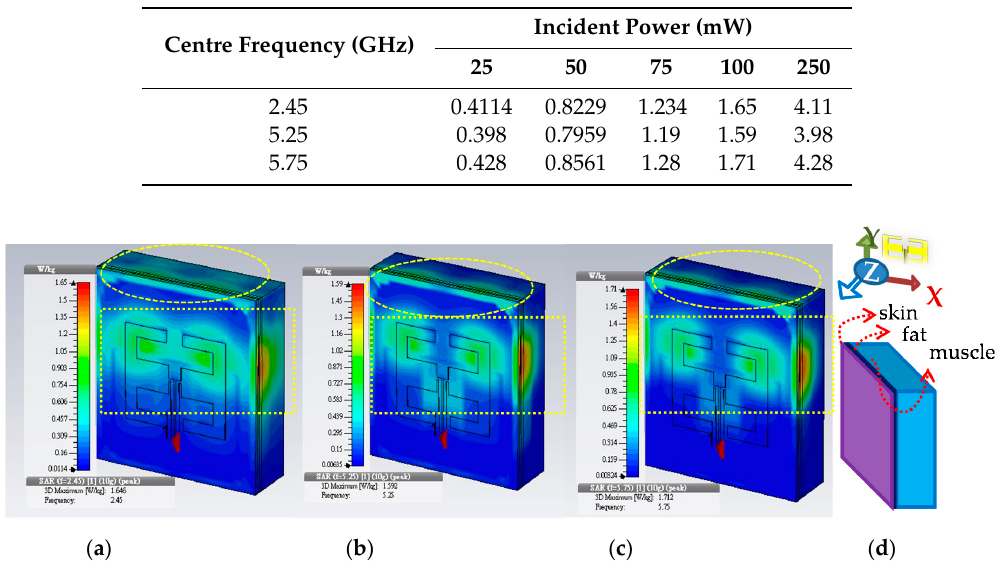
Table 3. Simulated average specific absorption rate (SAR) (10 g) peak value in W / kg.